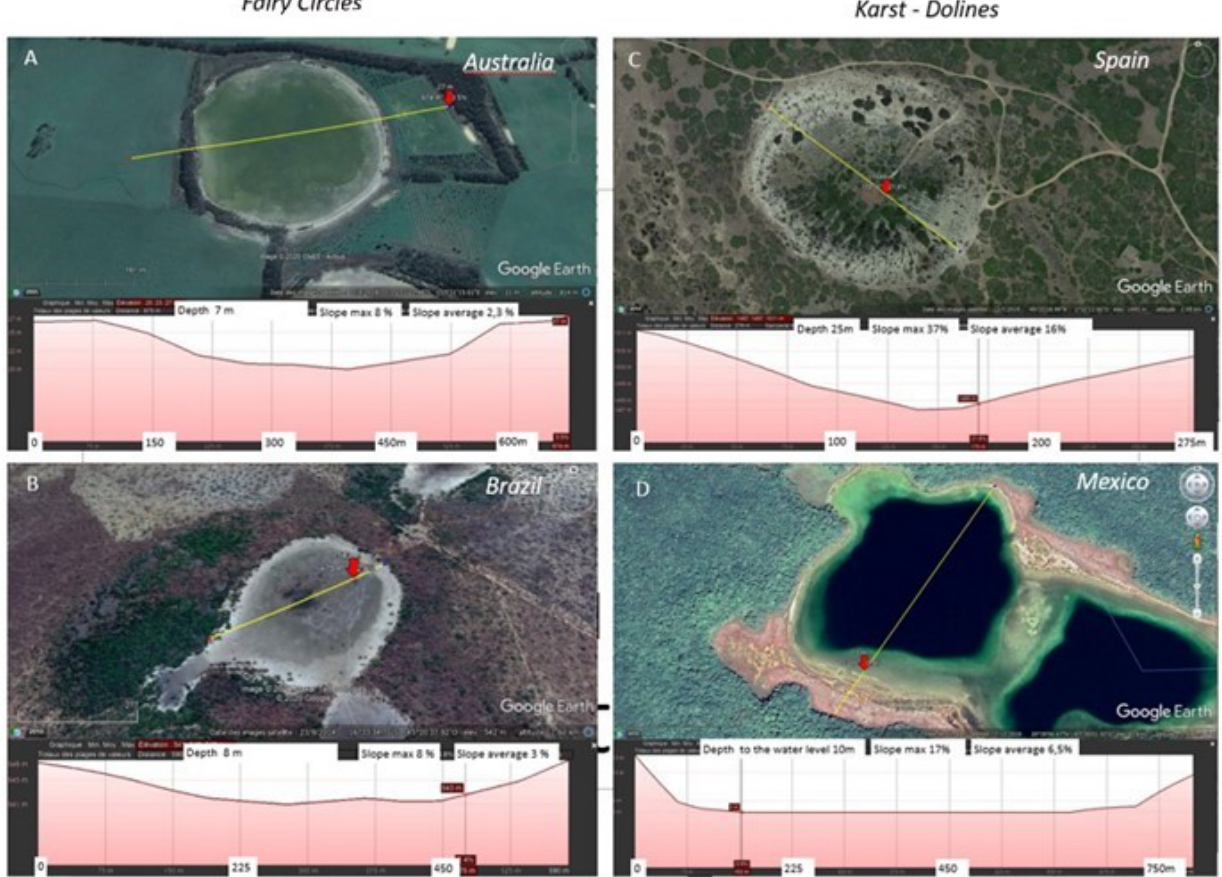
Figure 7. Examples of depressions. Left fairy circles , respectively in Australia ( A ) and Brazil ( B ). Right karstic dolines. The one in Spain ( C ) is dry and so the exact depth could be measured. At the opposite extreme is the Yucatan karstic system ( D ) where the bottom of the sinkholes is an active cave passage which is always filled of water. The depth measured by satellite images is therefore a minimum. Note the shape is similar but that the depth and especially the slopes are different between the two kinds of